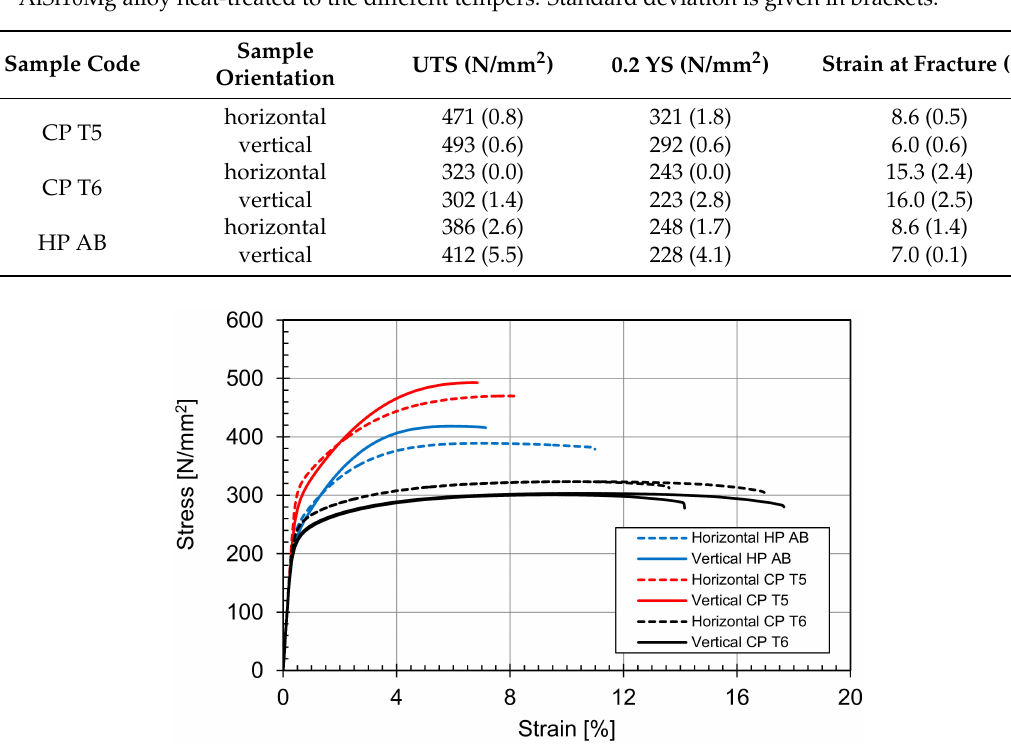
Figure 8. Tensile curves of the SLM-processed AlSi10Mg alloy heat-treated to the different